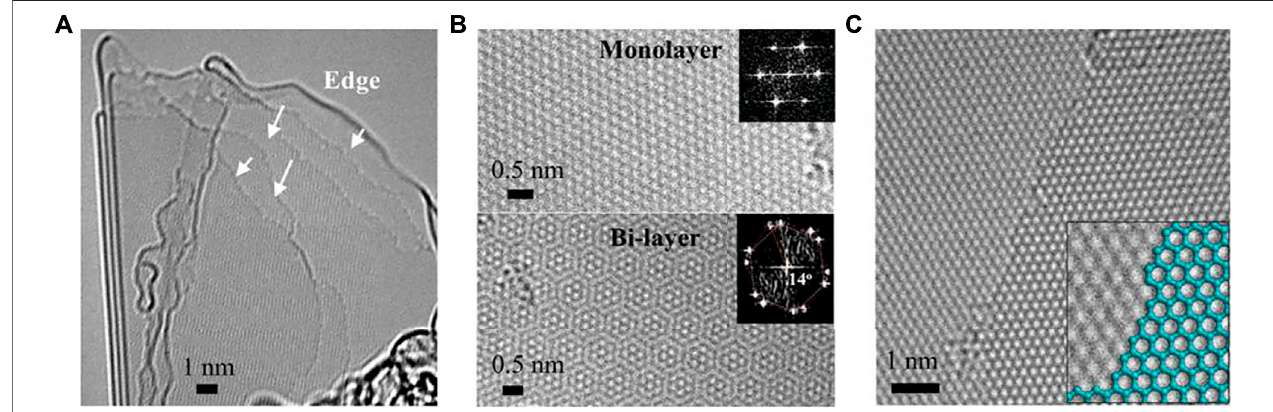
FIGURE6| Atomic-scaleTEMimages ofcrystallinemicro-sizedgraphene: (A) Crystalline-graphenewithanexposededge-richstructure; (B) monolayergraphene (upper) andbilayergrapheneexhibiting14 ° stackingrotation (bottom) ; (C) AAstackingexhibitingzigzagedges.The fi gureisreprintedwithpermissionfromMuramatsu et al., 2014, Copyright 2014, John Wiley and